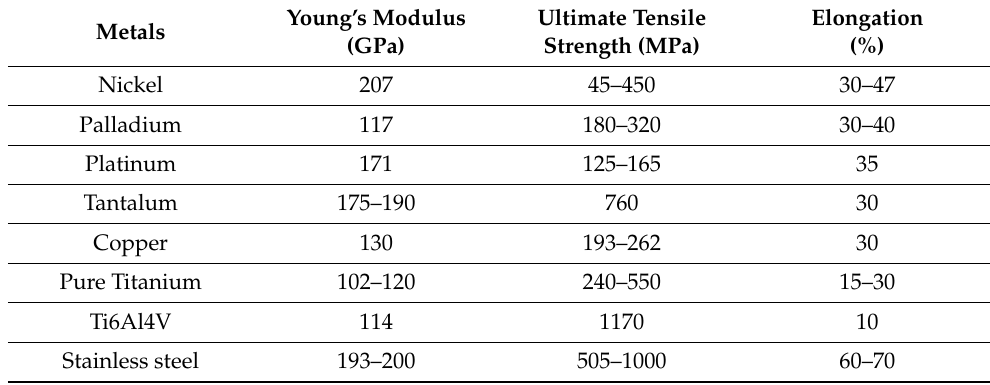
Table 2. Mechanical properties of metals used for the manufacture of metal-based MN arrays